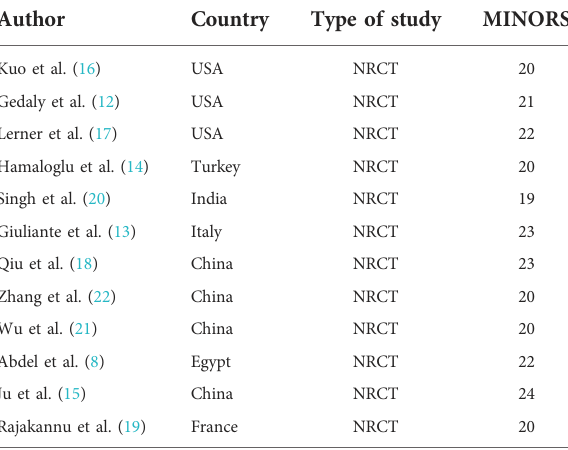
TABLE 1 Characteristics of studies included in this meta-analysis of enucleation vs. hepatectomy for hepatic